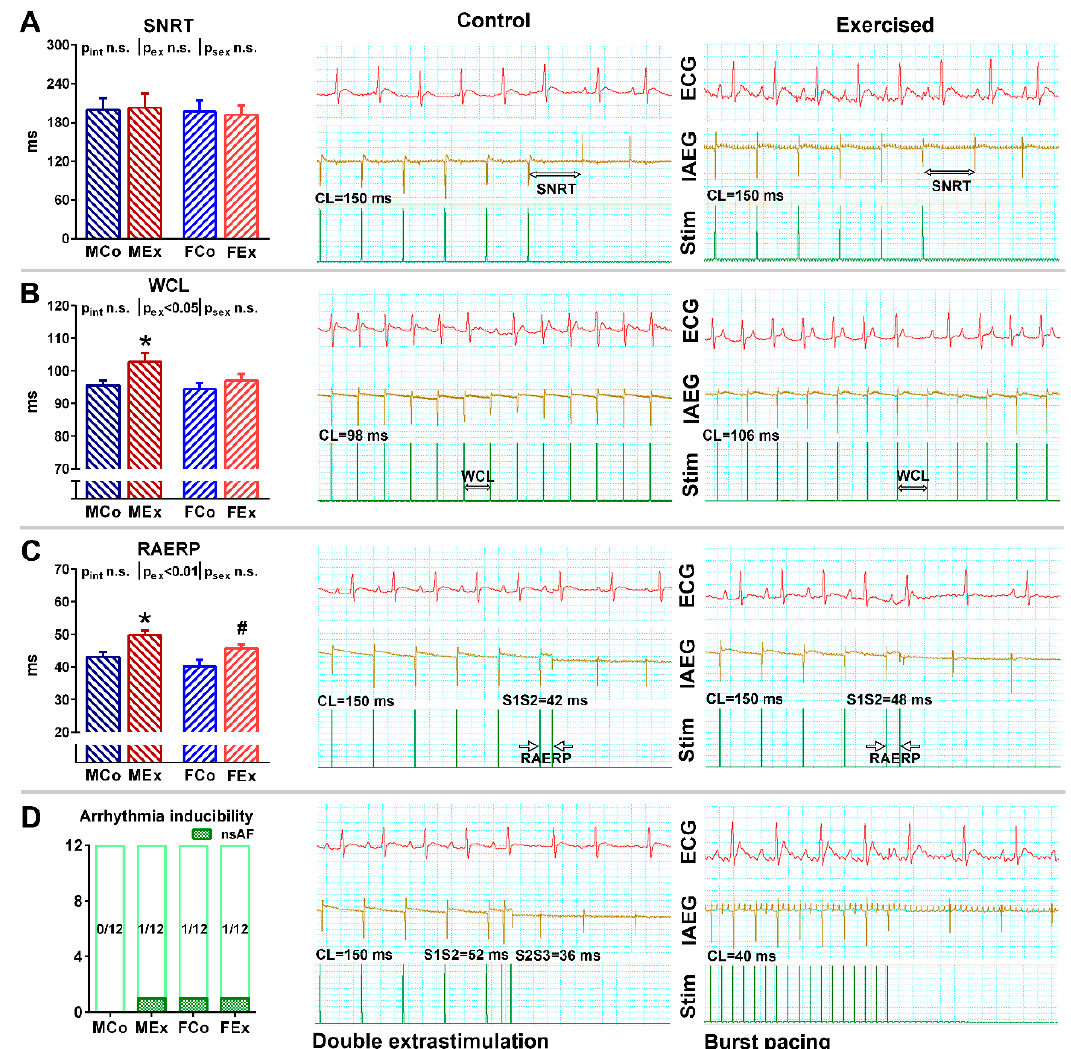
Figure 2. ( A ) Sinus node recovery time (SNRT) data in male control (MCo), male exercised (MEx), female control (FCo), and female exercised (FEx) animals and representative electrocardiogram (ECG, lead II), intraatrial electrogram (IAEG), and stimulation marks (Stim) during the SNRT maneuver in one control and exercised animal. ( B ) Wenckebach cycle length (WCL) data and representative ECG, IAEG, and Stim curves of one control and exercised animal. The longest cycle length (CL) inducing Mobitz type-1 AV-block constituted the WCL. ( C ) Right atrial refractory period (RAERP) data and representative ECG, IAEG, and Stim curves from an exercised and a control animal. ( D ) Atrial arrhythmia inducibility by using double extra stimulation (DES) or burst pacing protocol and representative ECG, IAEG, and Stim curves from an exercised and a control animal. CL: cycle length. Values are means ± SEM. * p < 0.05 vs. MCo, # p < 0.05 vs. FCo. p ex and p sex : p -value of two-way analysis of variance (ANOVA) factors exercise and sex, respectively; p int : interaction p -value of two-way ANOVA.